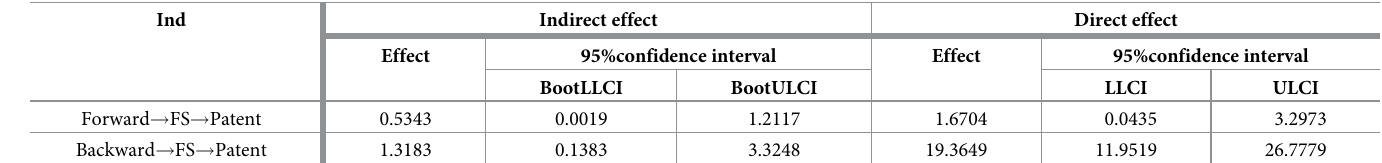
Table 4. Intermediary test of financing